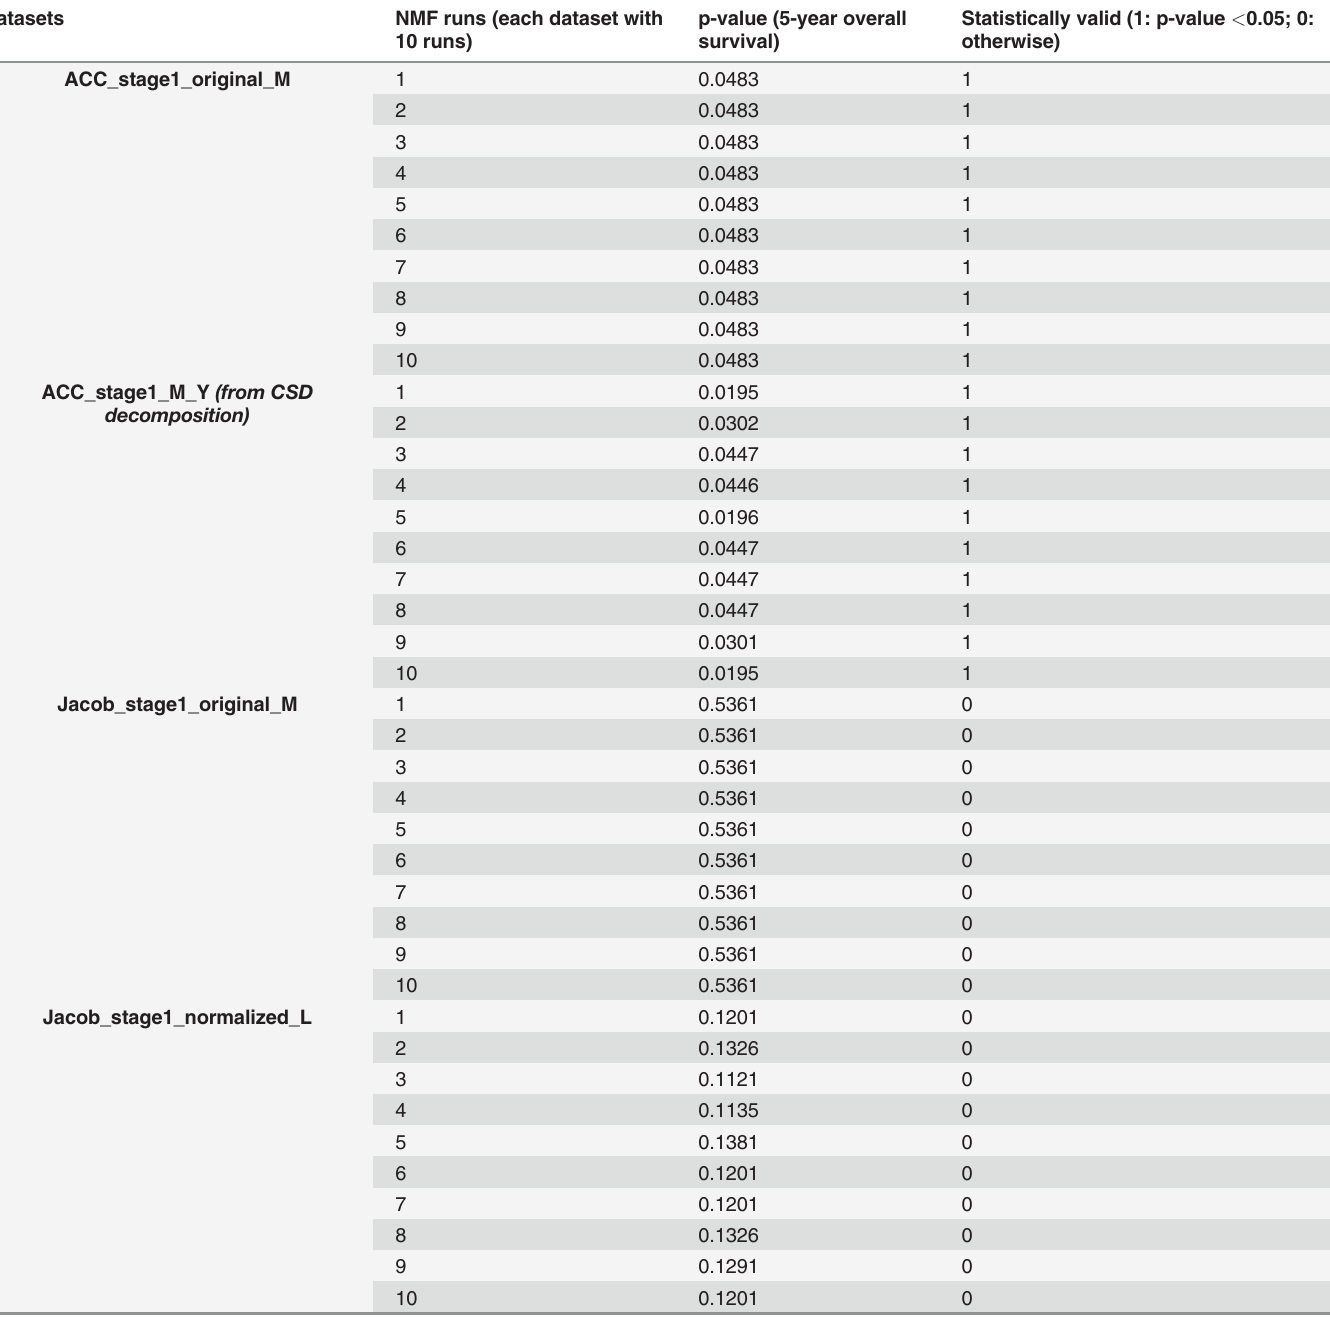
Table 1. Performance of NMF (with k = 2 sample clusters) on original matrices Ms or normalized matrices L, compared with its performance on CSD decomposed matrices M_Y or L_Y.